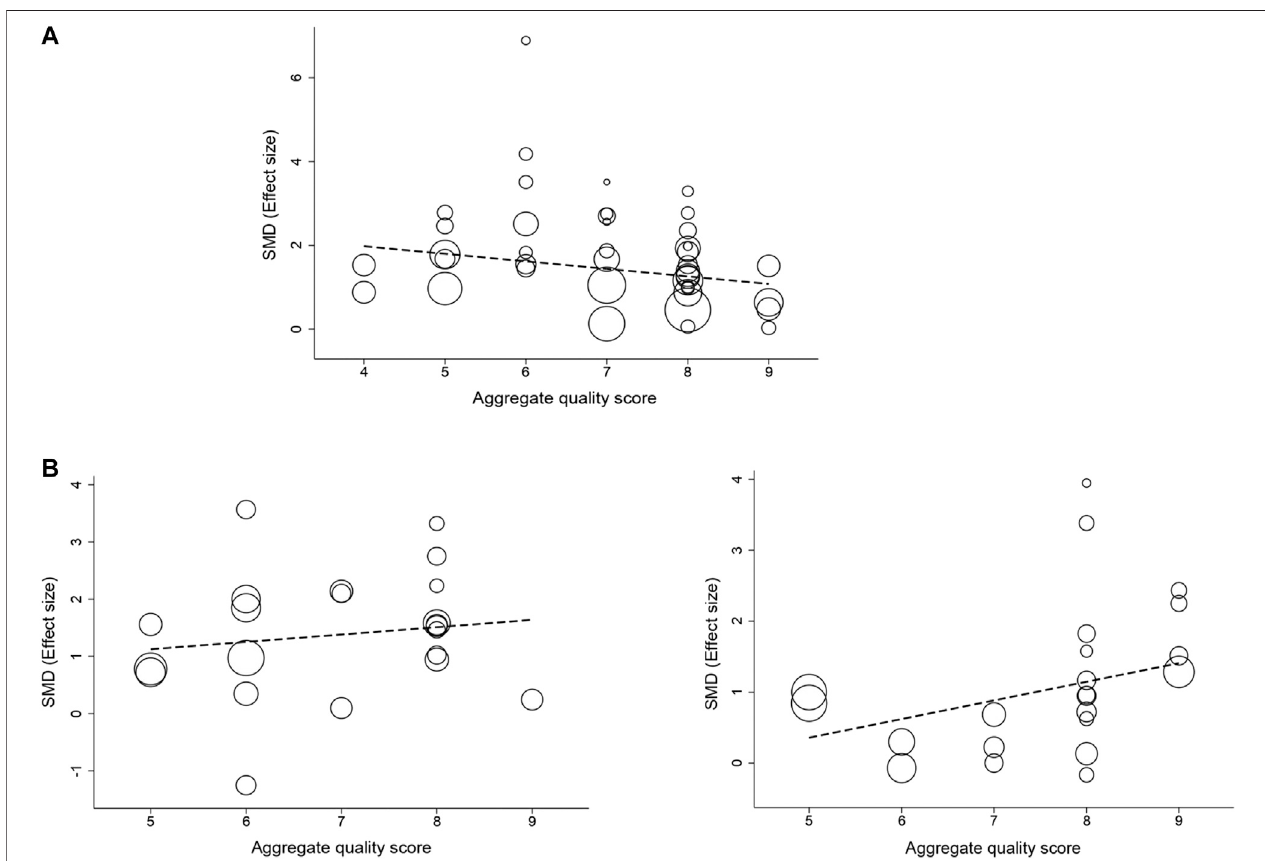
FIGURE4| Thecorrelationbetweenstudyqualityscoreandeffectsizeinintracerebralhemorrhage (A) ,infarctsize (B) ,andneurobehavioralscore (C) .Thesizesof hollow circles represent the relative number of animals tested for each intervention.